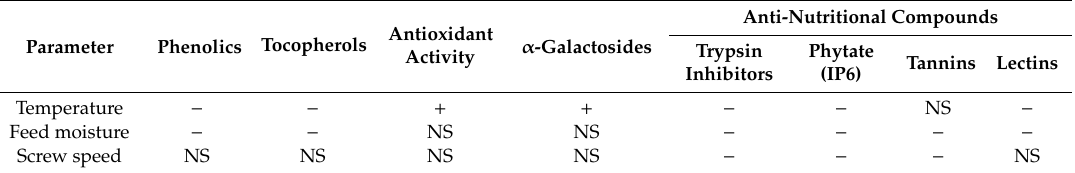
Table 5. E ff ect (positive / negative) of the increase in the main processing parameters of extrusion cooking on the content of functional and anti-nutritional compounds of legume-based extruded